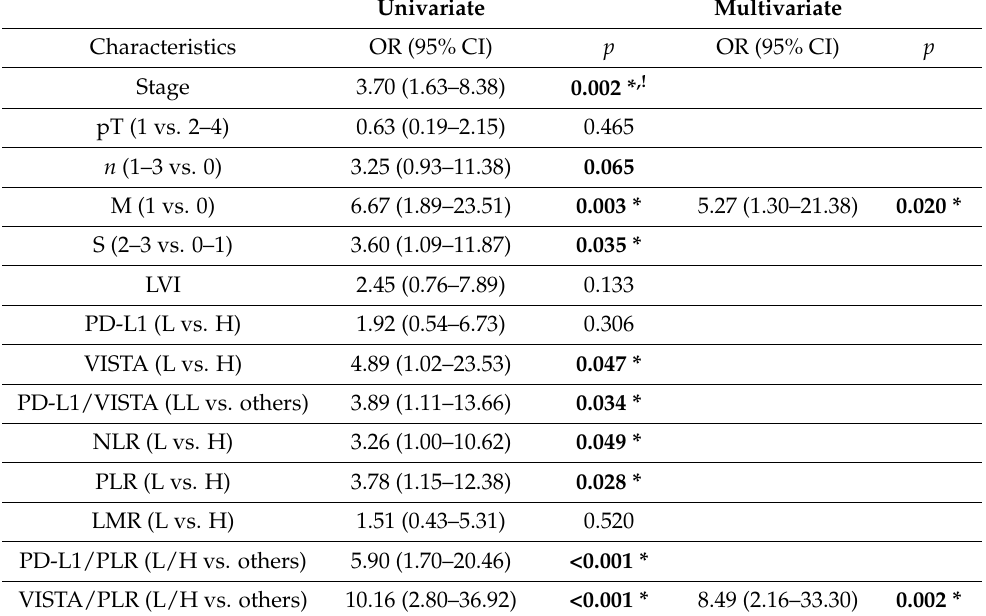
Table 4. Univariate and multivariate logistic regression analysis of factors predicting event (pro-